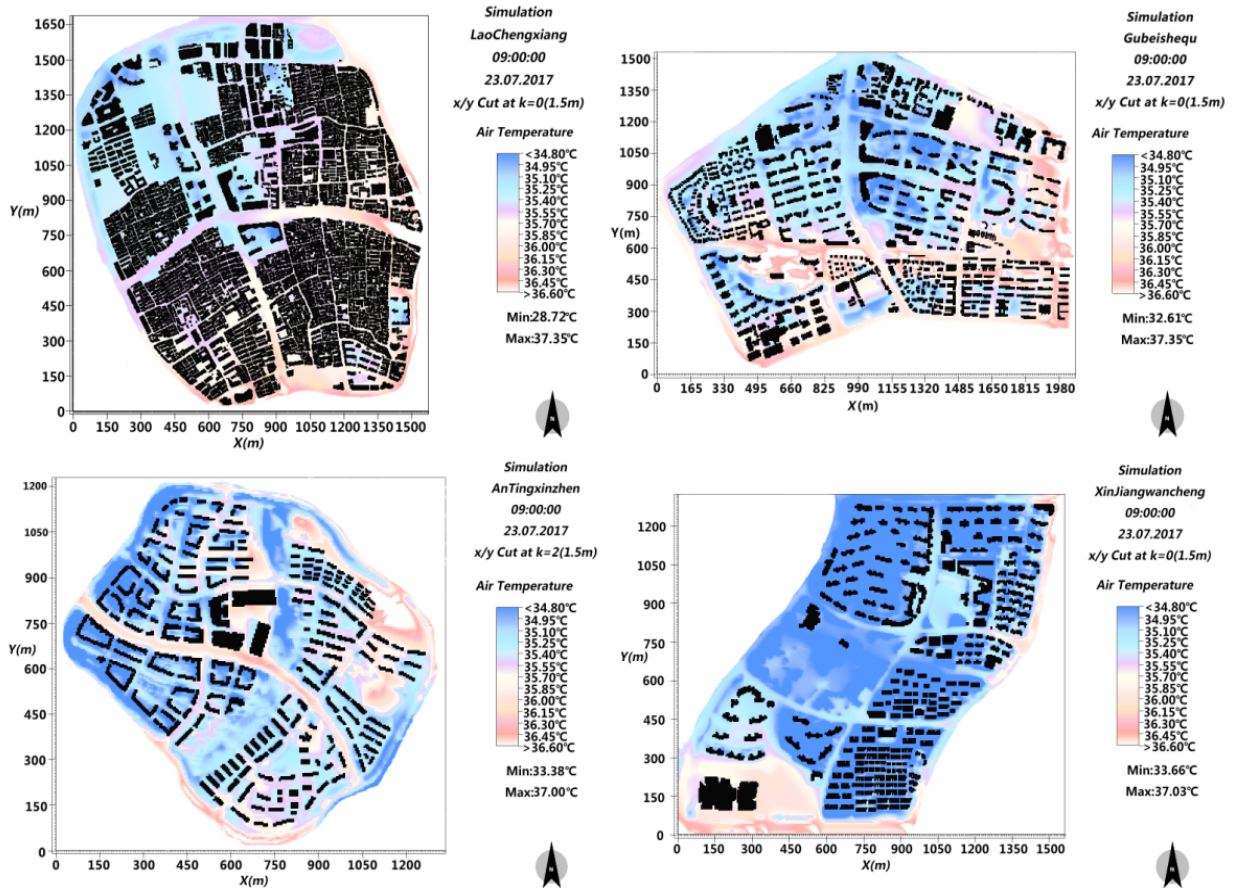
Figure A1. Spatial distribution of the air temperature in the four areas at 9:00 p.m., 1.5 m (left upper: Old downtown; right upper: Gubei international community; left lower: Anting New Town; lower right: New Jiangwan Town).